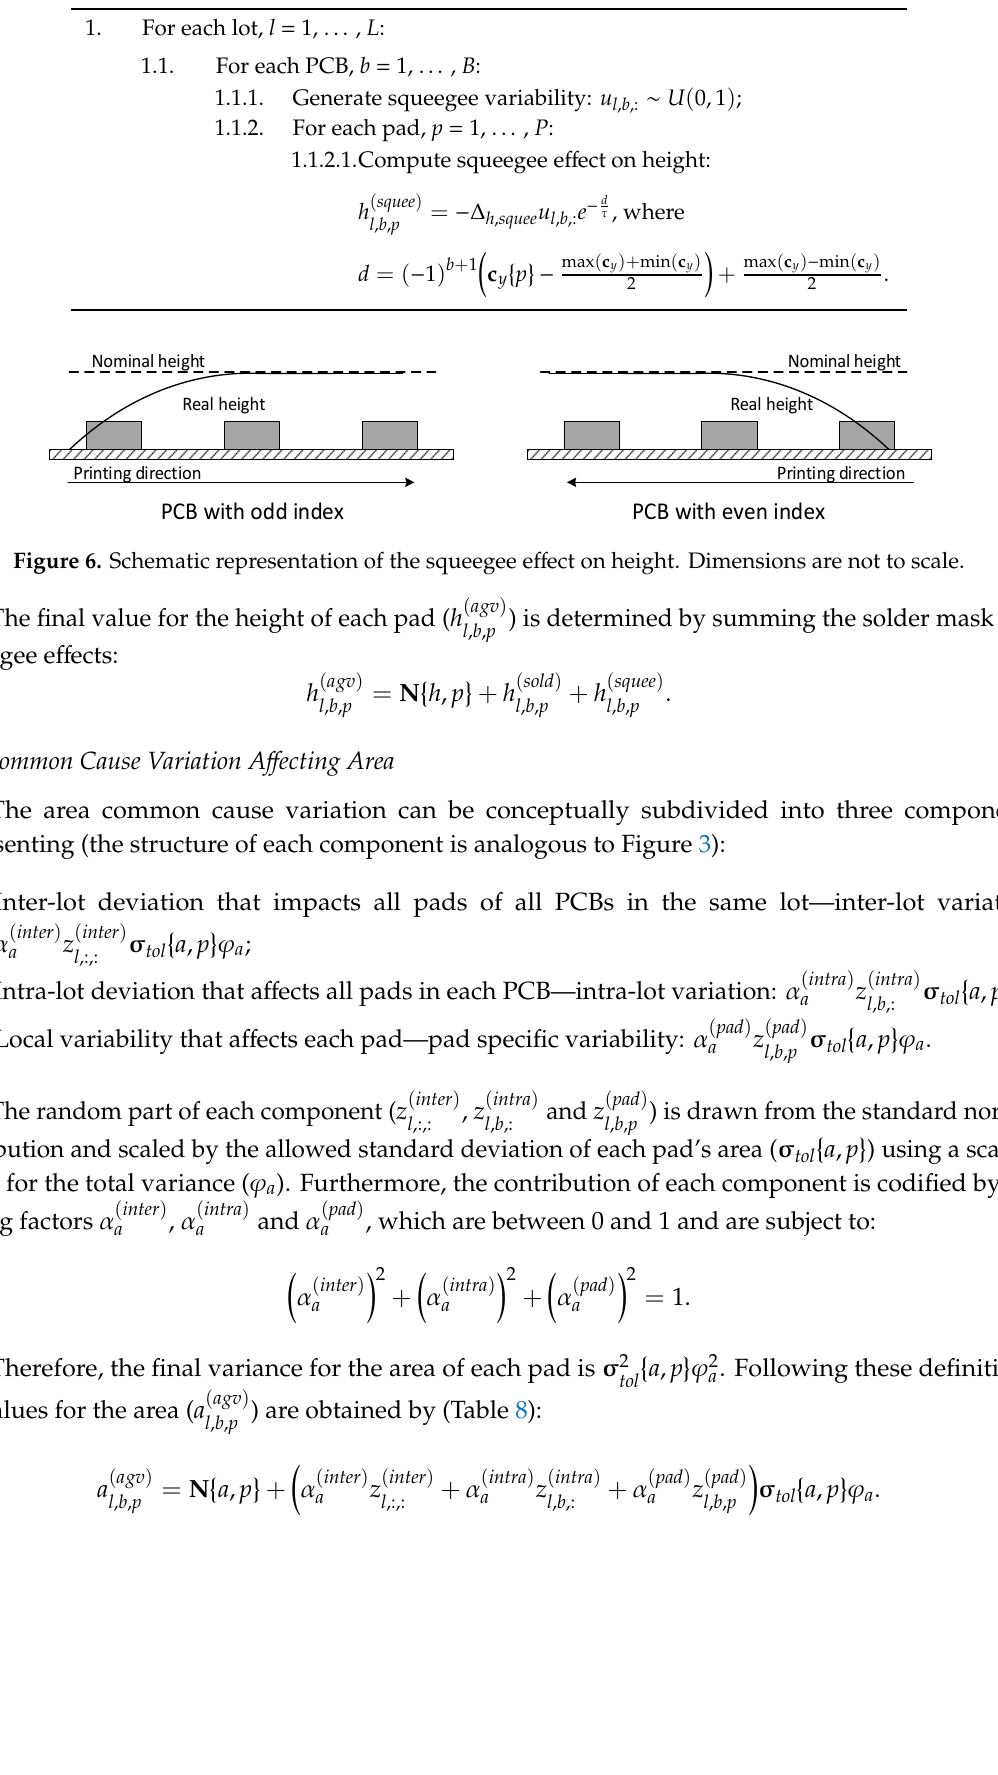
Table 7. Pseudo-code for generating the squeegee effect on height.